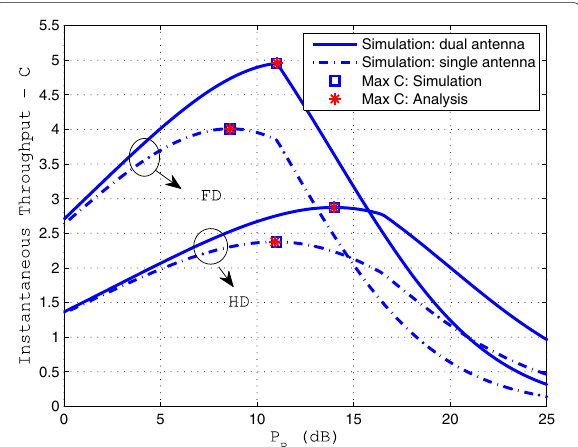
Simulation: dual antenna Simulation: single antenna Max C: Simulation Max C: Analysis